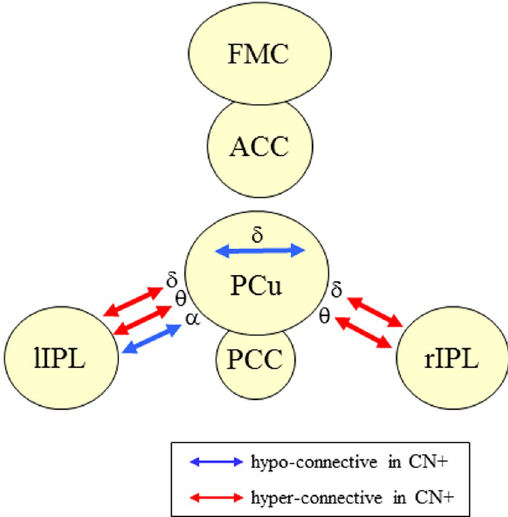
Figure 2. Summary of the network alteration in CN + subjects. The network motifs that showed statistically significant differences in CN + subjects compared with CN − subjects are shown. The blue and red arrows indicate hypo-connective motifs (CN + subjects < CN − subjects) and hyper-connective (CN + subjects > CN − subjects) motifs, respectively. The Greek characters indicate the frequency bands that showed significant differences ( δ : delta, θ theta, α : alpha). CN + : cognitively normal PiB-positive, CN − : cognitively normal PiB-